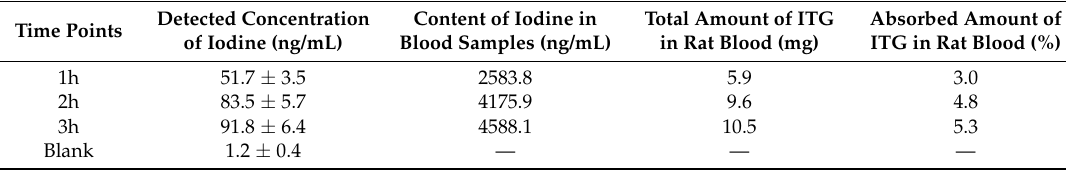
Table 7. Content of iodine and ITG in rat blood at different times.